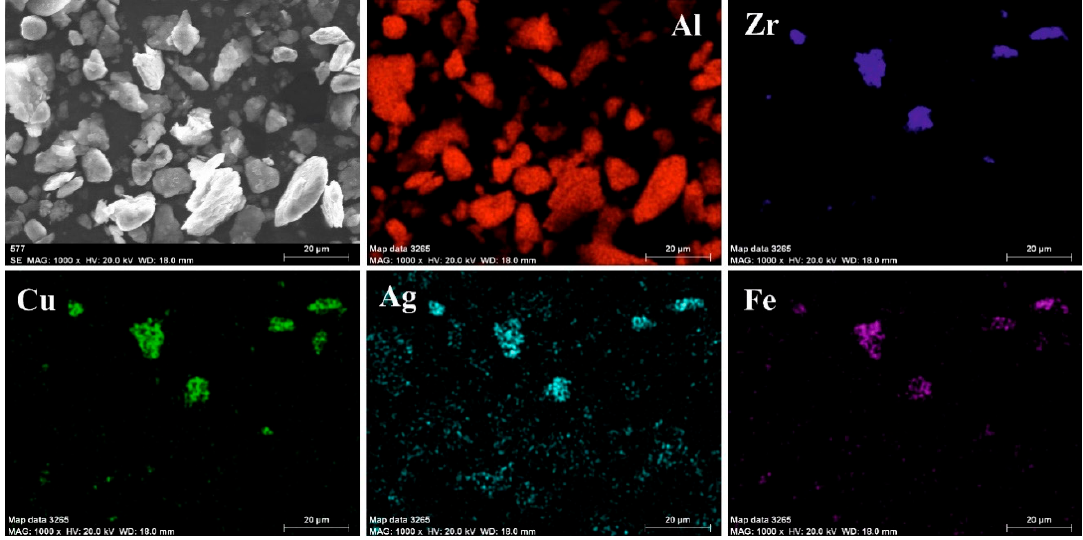
Figure 4. SEM micrograph and characteristic compositional XEDS-SEM mapping of 5 h milled powder.